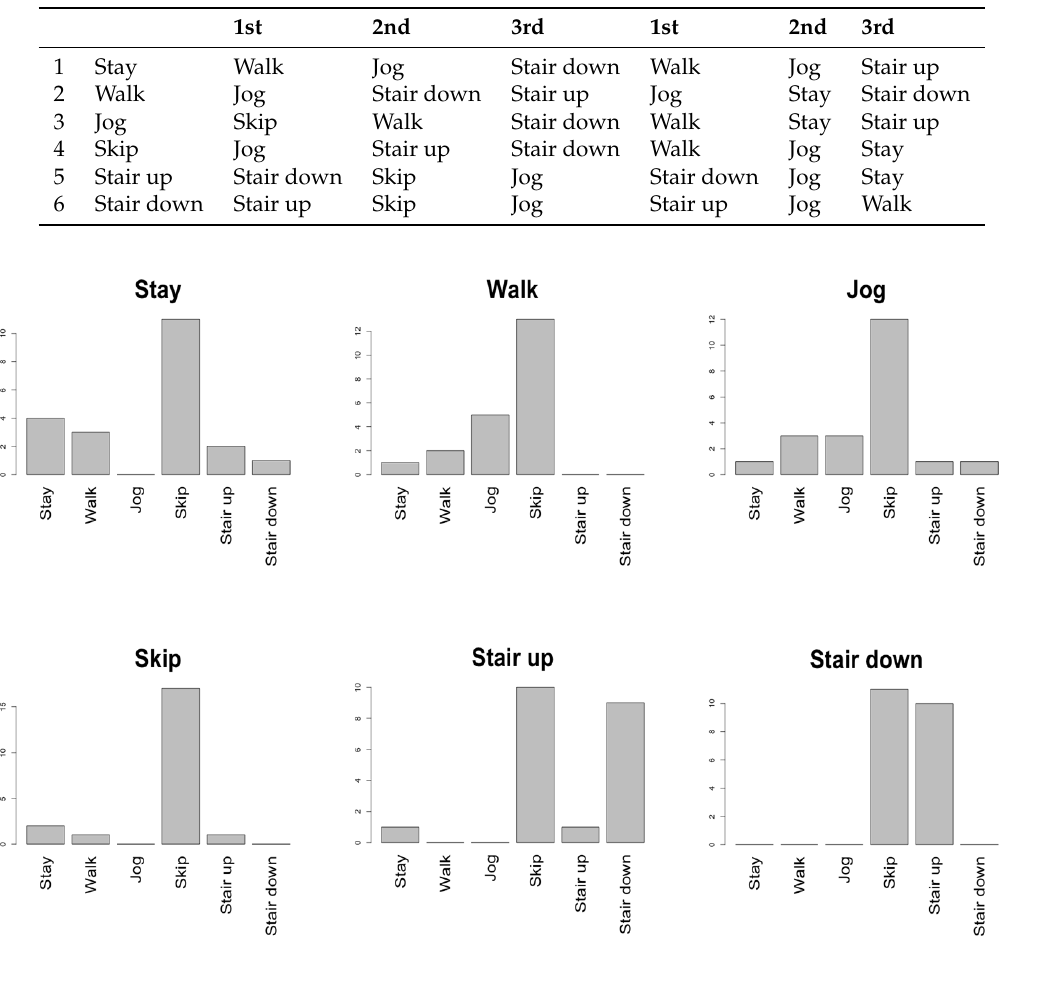
Table 8. Top 3 nearest words in the attribute space (left) and the embedding space (right) for the HASC dataset.